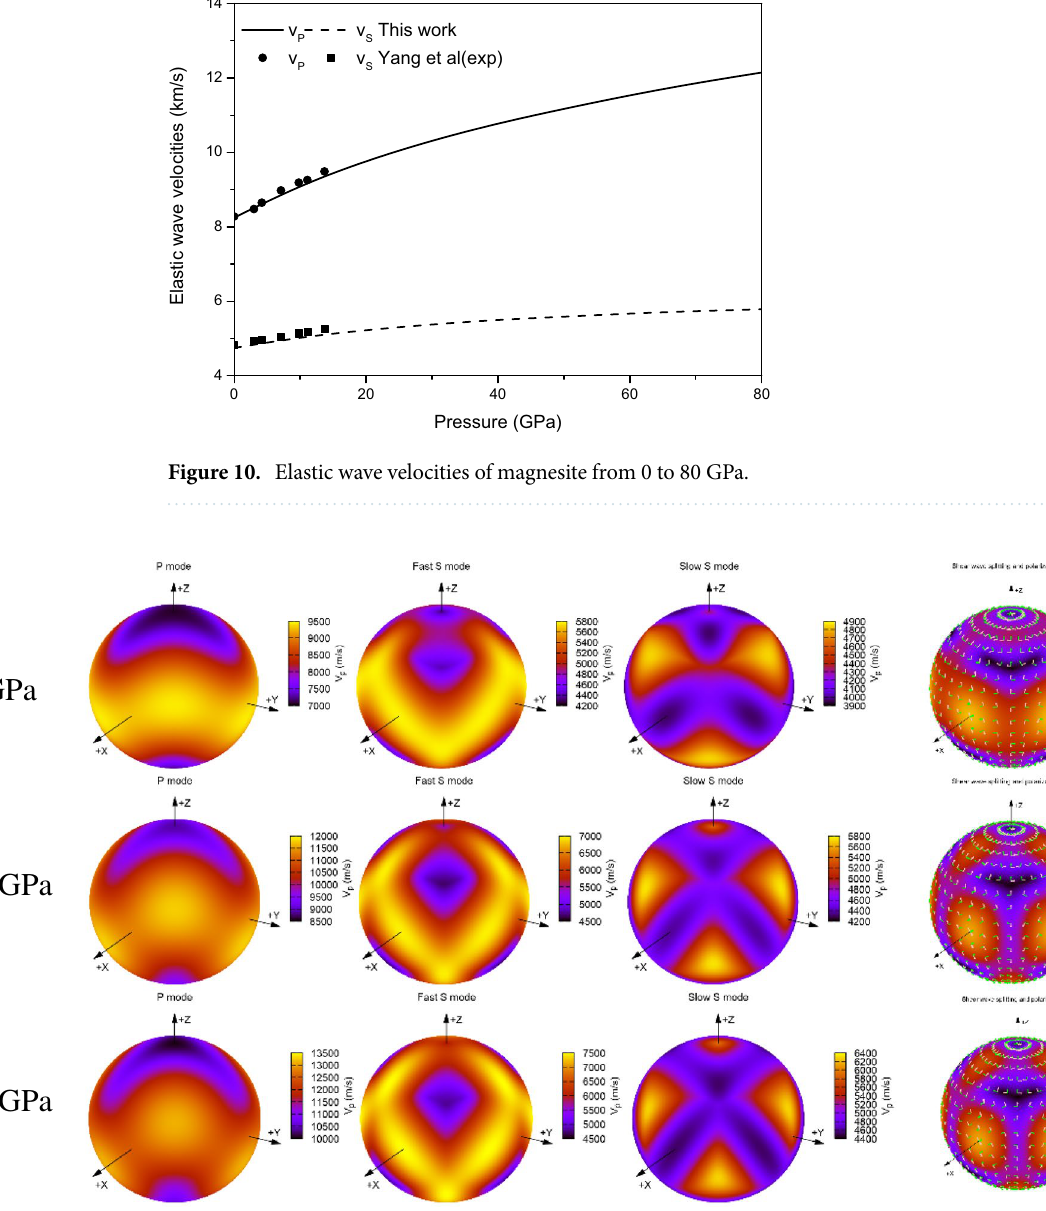
Figure 11. 3D representation of the elastic wave velocities of the P-modes and S-modes (left) and the shear wave splitting and polarization vectors of the S-modes (right) for magnesite in different propagation directions at various